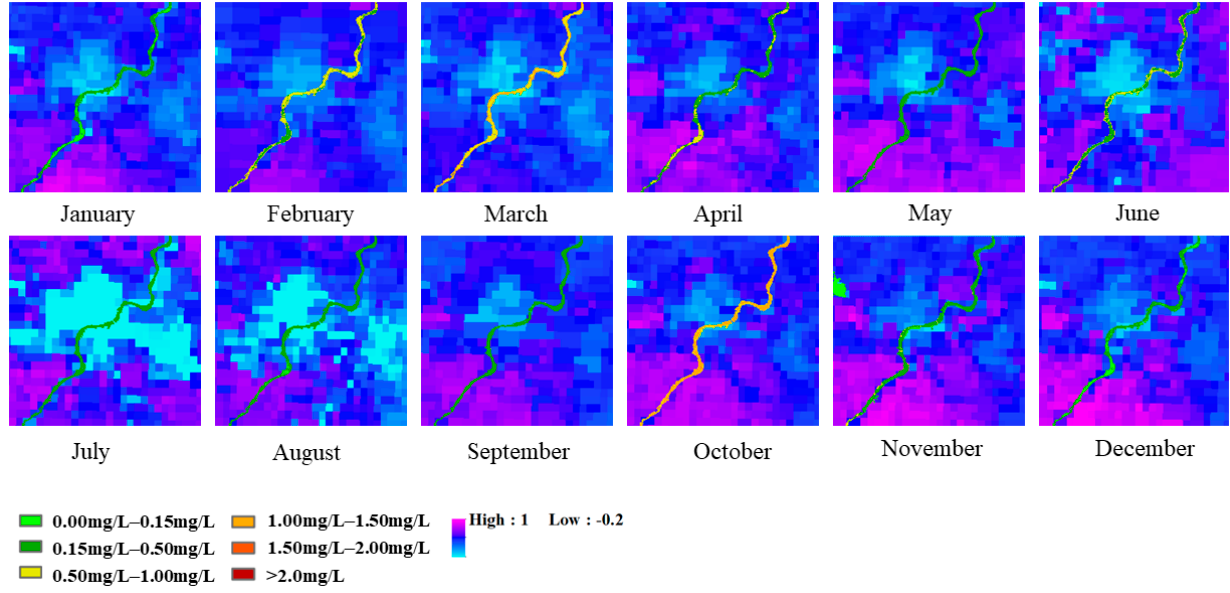
Figure 14. Region (d) monthly NH 3 -N concentration and NDVI changes.